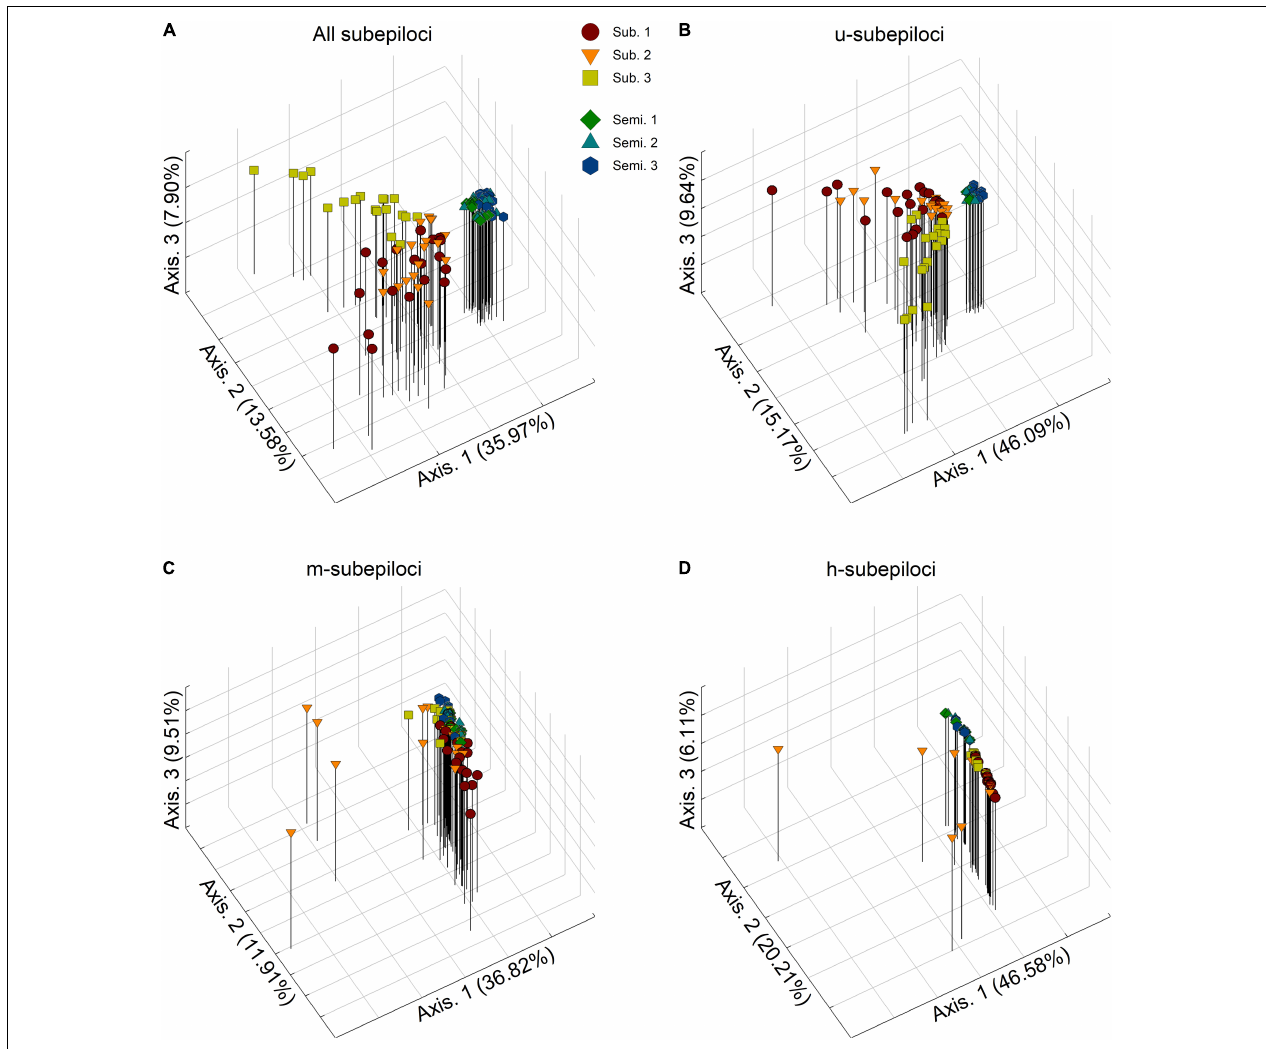
FIGURE 2 | Results of principal coordinate analyses (PCoA) based on (A) all subepiloci, and (B) u-, (C) m-, and (D) h-subepiloci of MSAP. Semi. and Sub. stand for the semi-submergence and submergence treatment,